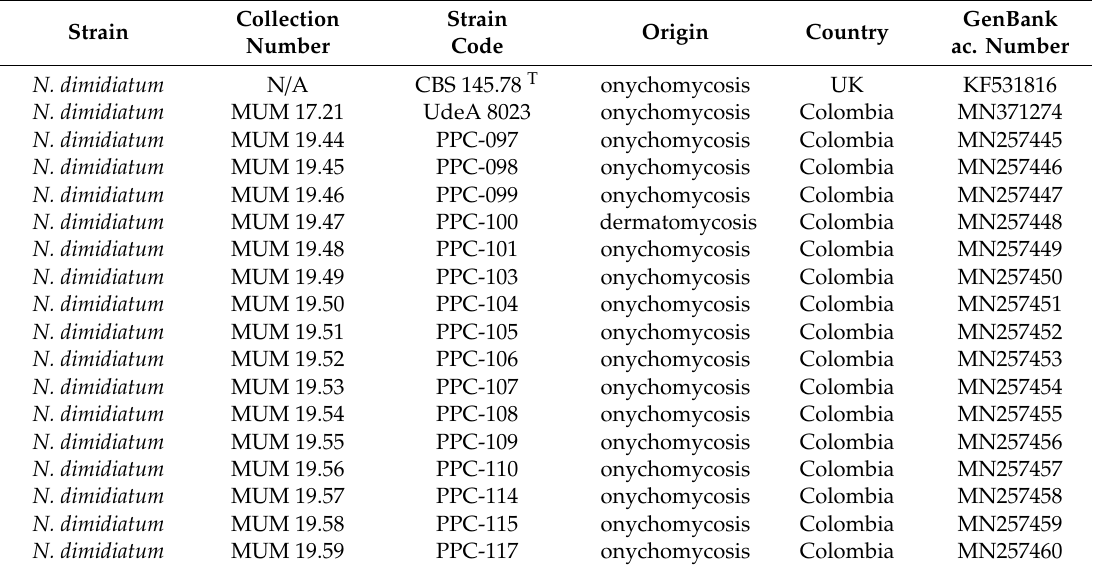
Table 1. Clinical and reference fungal strains included in this